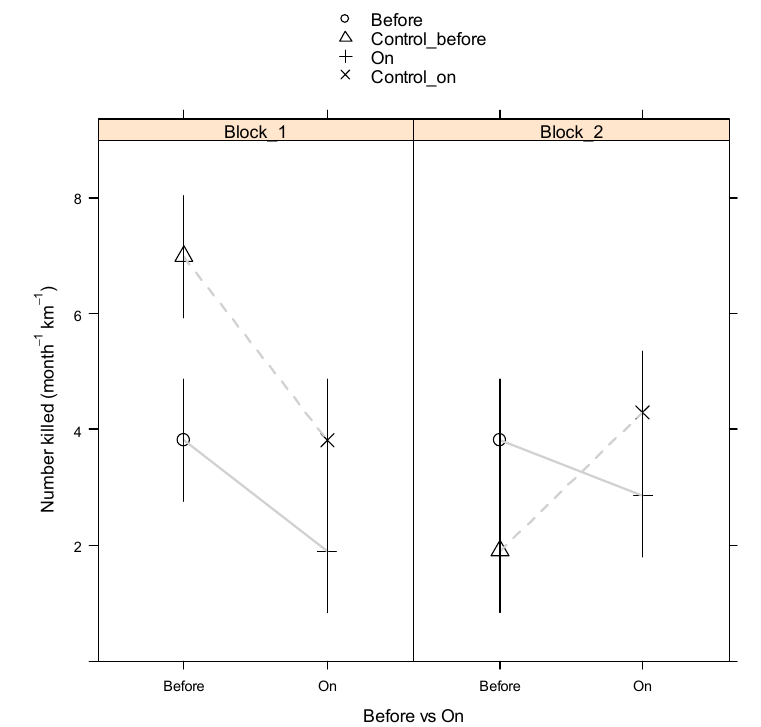
Figure 2. Standardised roadkill rate (month -1 km -1 ) for Bennett’s wallaby for Periods 2 to 5 for MBACI means by Block. Single SE bars are shown.